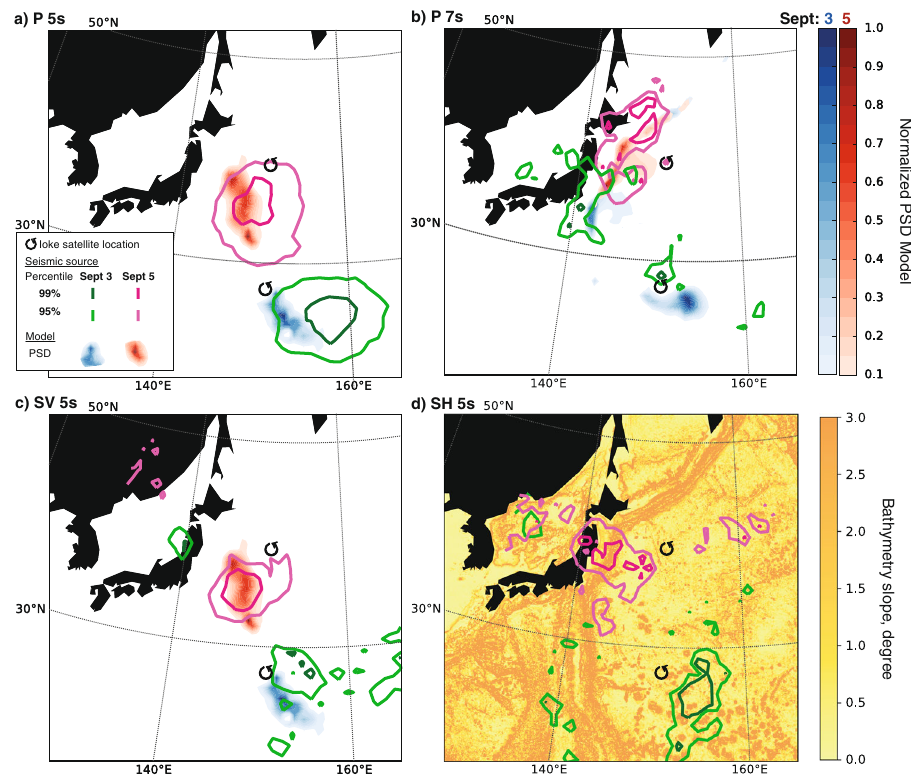
Fig. 2 Observed and modeled extended seismic sources of typhoon Ioke. Compressional P-wave sources are shown on the top two panels — at ( a ) 5 s and ( b ) 7 s — while shear-wave sources are shown on the bottom two panels — ( c ) SV-wave sources at 5 s, and ( d ) SH-wave sources at 5 s. Observed seismic sources generated by typhoon Ioke are denoted by contour lines (green contours for sources on September 3 and pink contours for sources on September 5). Modeled P- and SV-wave sources (panels a – c ) represent the pressure PSD in the presence of coastal re fl ection, modulated by the ocean site effect, and they are shown as colored shadows (blue for sources on September 3 and red for sources on September 5). Observed SH-wave sources in panel d are compared to the slope of the